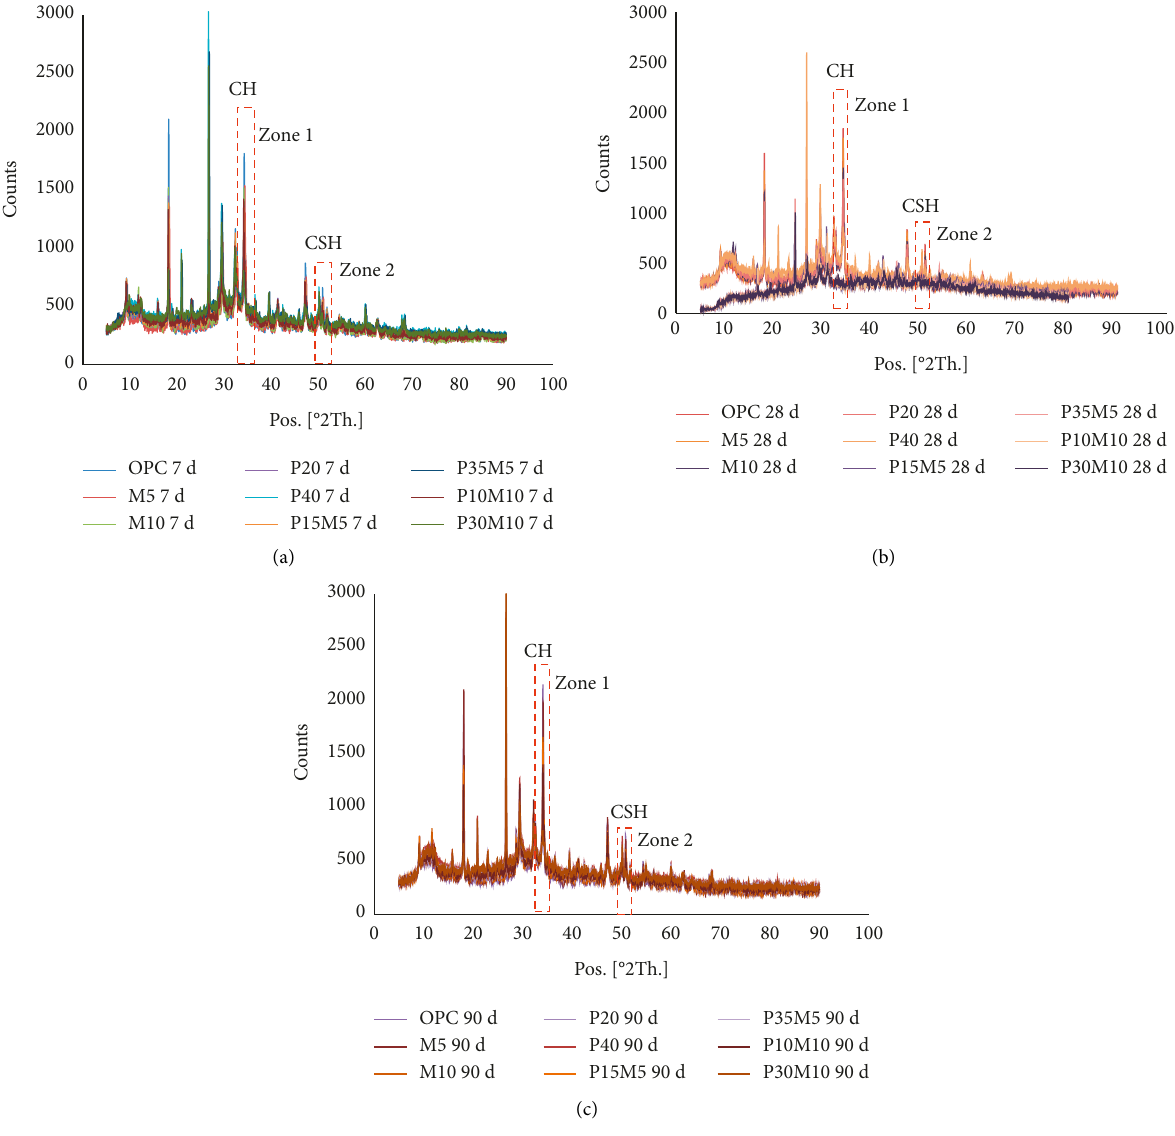
Figure 5: Samples counts analysis by zone for 7 to 90 days age.